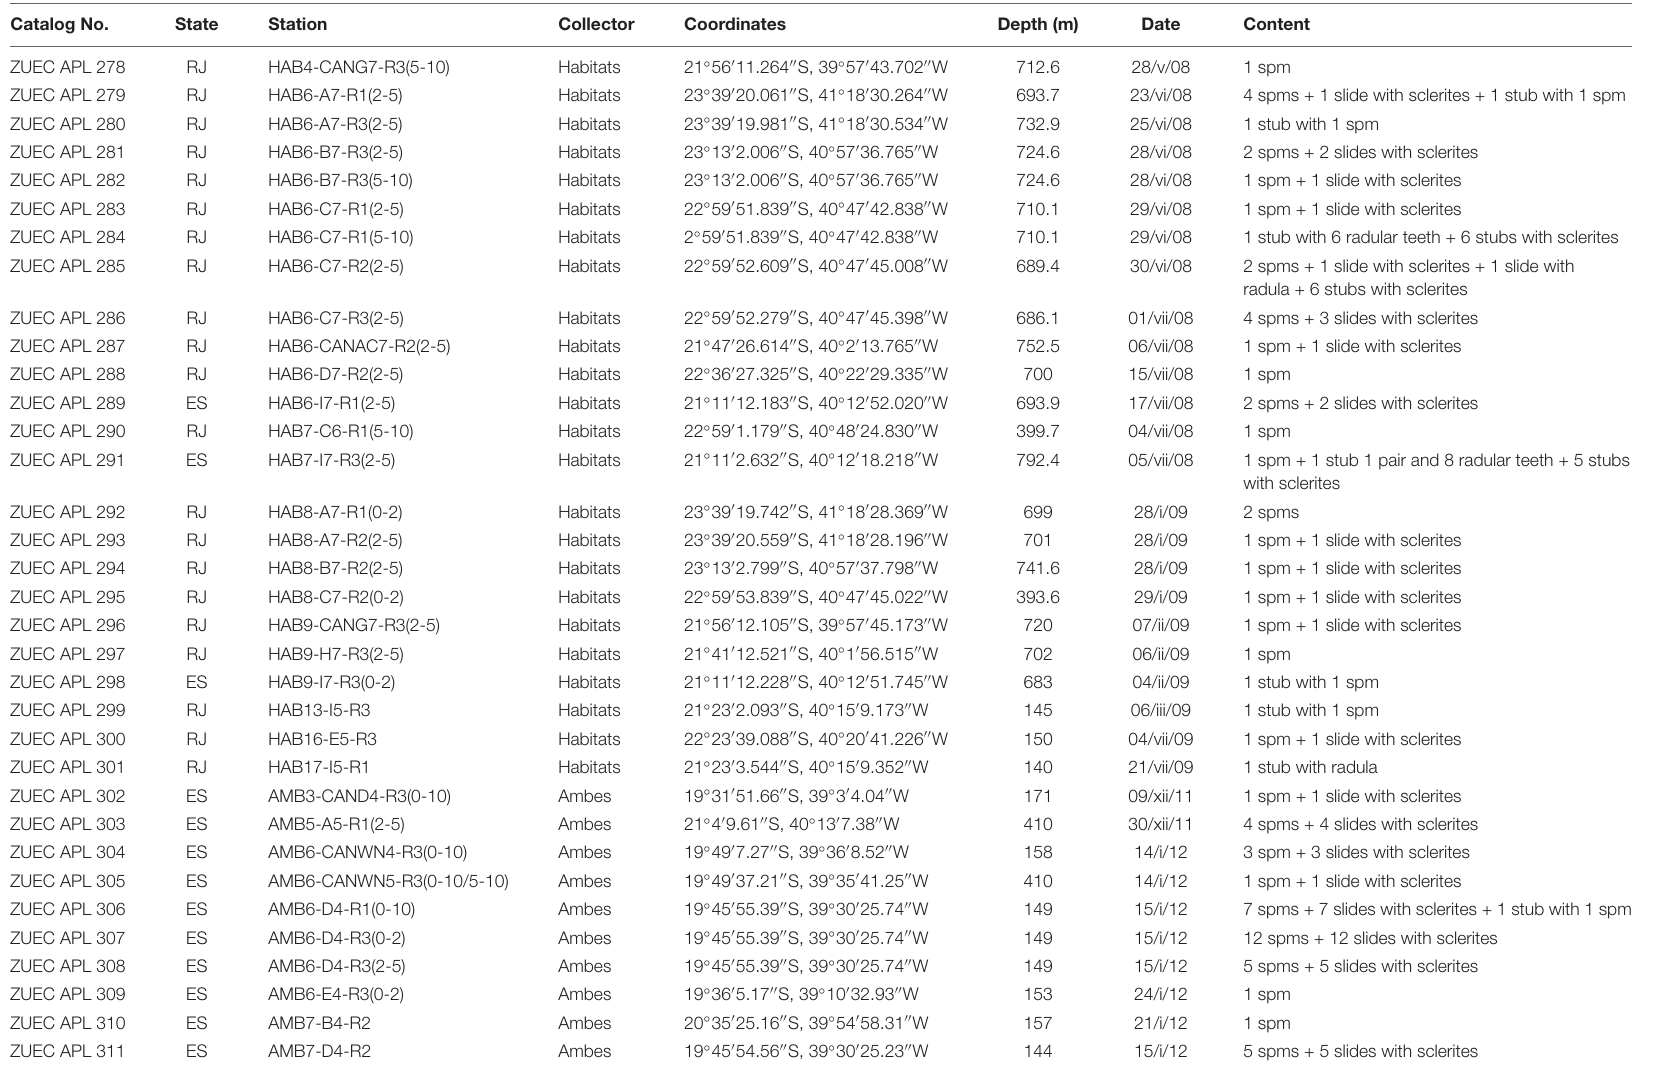
TABLE 1 | Scutopus variabilis sp. nov. Paratype samples. Catalog